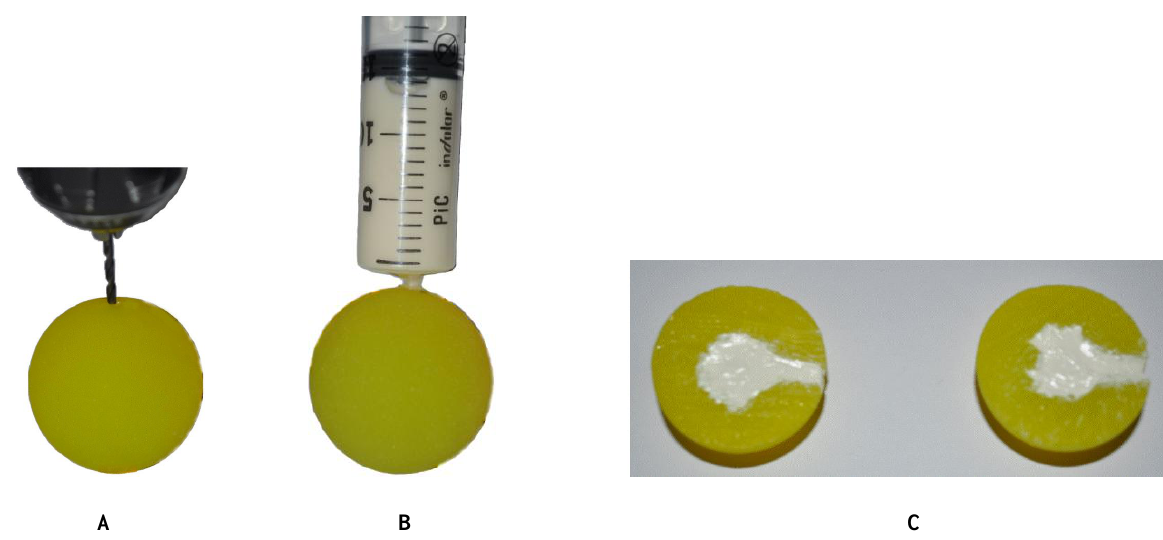
FIGURE 7. Construction of phantoms. (A) Each ball was drilled and a volume of 10 cm 3 was emptied. (B) A different quantity of acrylic glue was injected into each ball. (C) Section of phantom along the axis of drilling after glue consolidation. The foam of the glue filled in all empty spaces; 5 g of glue was injected into the left ball, 20 g into the right